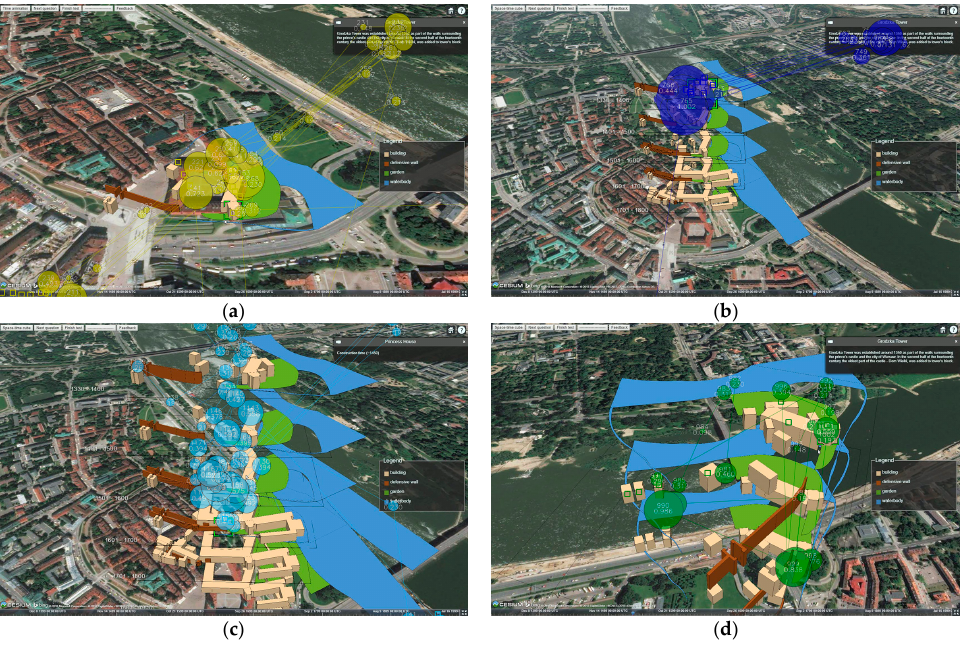
Figure 14. Searching strategies for Q2: ( a ) overview, temporal filter, and details-on-demand in the slider-based visualization; ( b ) overview and details-on-demand in the space–time cube; ( c ) overview, relate, and details-on-demand operations in the space–time cube; ( d ) zoom and relate operations in the space–time cube.